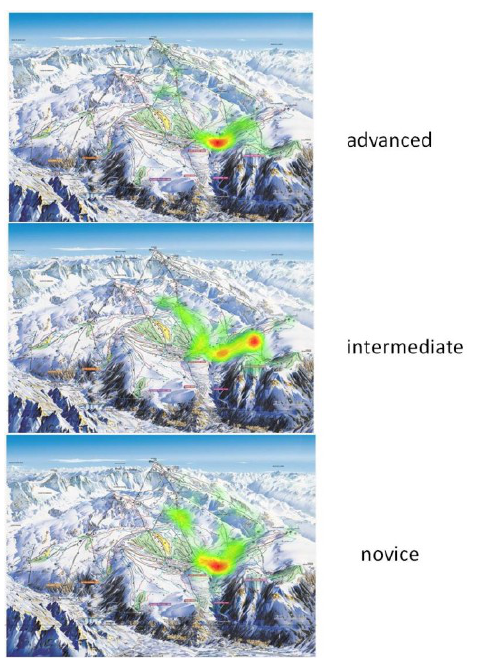
Figure 6. Examples of heatmaps for creating a route task (T2).